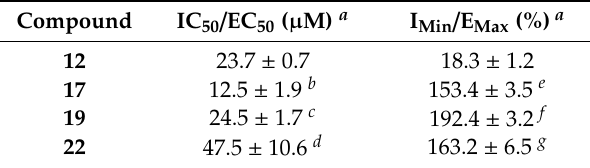
Figure 3. Dose response curves of top FGF14:Nav1.6 complex modulators. To determine potency (IC 50 or EC 50 ) and e ffi cacy (percent luminescence at the bottom or top plateau for inhibitors (I Min ) or enhances (E Max ), respectively) each compound was tested at 14 concentrations (range: 0.25–175 µ M; n = 4 replicates per concentration) using the LCA in 96-well plates. Data are shown as mean percent luminescence (relative to per plate 0.5% DMSO controls) values ± SEM. Non-linear regression curve fitting was performed using GraphPad Prism 8 to determine potency and e ffi cacy values for each compound, as shown in Table 2. Table 2. Potency and e ffi cacy of top